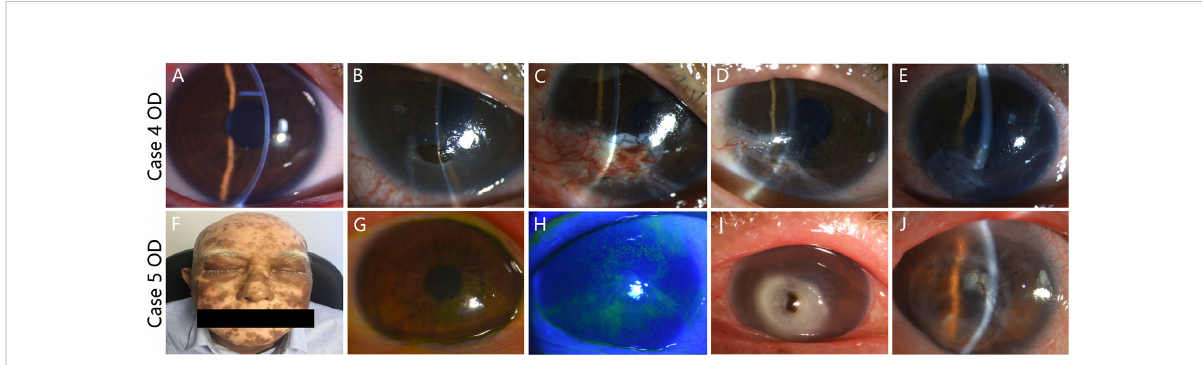
FIGURE 2 oGVHD development in Cases 4 and 5. Slit lamp photographs at the time of fi rst presentation to ophthalmology department (A) , corneal perforation (B) , post-CFC surgery (C) , conjunctival fl ap retraction and corneal dissolution progression (D) , and post-keratoplasty surgery (E) in Case 4 were presented. The BCVAs of Case 4 at fi rst presentation, corneal perforation, and last follow-up visit were 20/32, 20/100, and 20/40, respectively. Meanwhile, Case 5 had vitiligo-like manifestation associated with GVHD (F) . The slit lamp photograph (G) and corneal fl